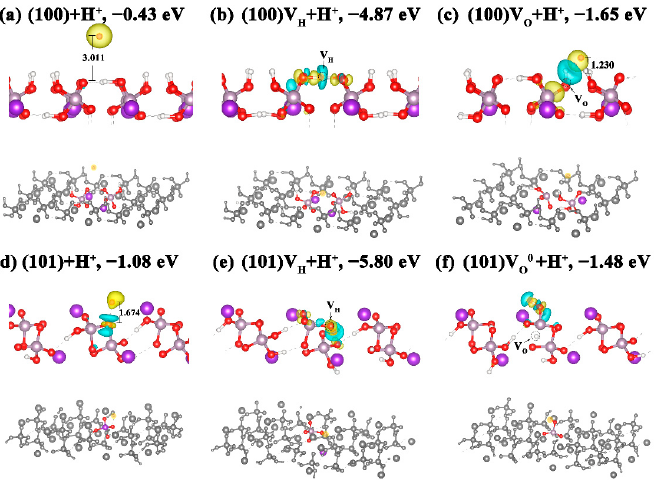
Figure 4. Local and overall structures as well as the charge-density difference maps of H + adsorbed on (100) and (101) surfaces. ( a ) Perfect (100) surface; ( b ) (100) surface with a V H defect; ( c ) (100) surface with a V O defect; ( d ) perfect (101) surface; ( e ) (101) surface with a V H defect; ( f ) (101) surface with a V O defect. Yellow and blue regions represent electron accumulation and depletion, respectively. The corresponding adsorption energy is listed at the top of each figure.